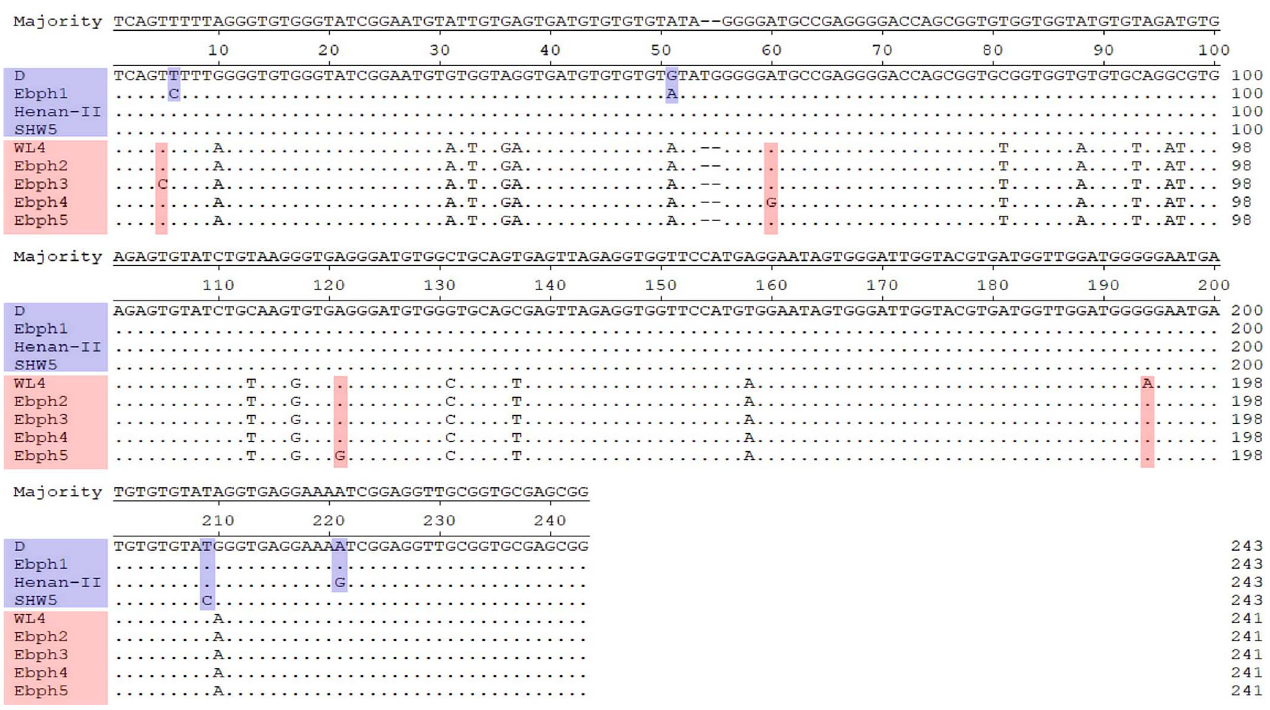
Fig. 1. Nucleotide sequence diversity at the ITS region of Enterocytozoon bieneusi genotypes obtained in this study in comparison with related reference sequences.